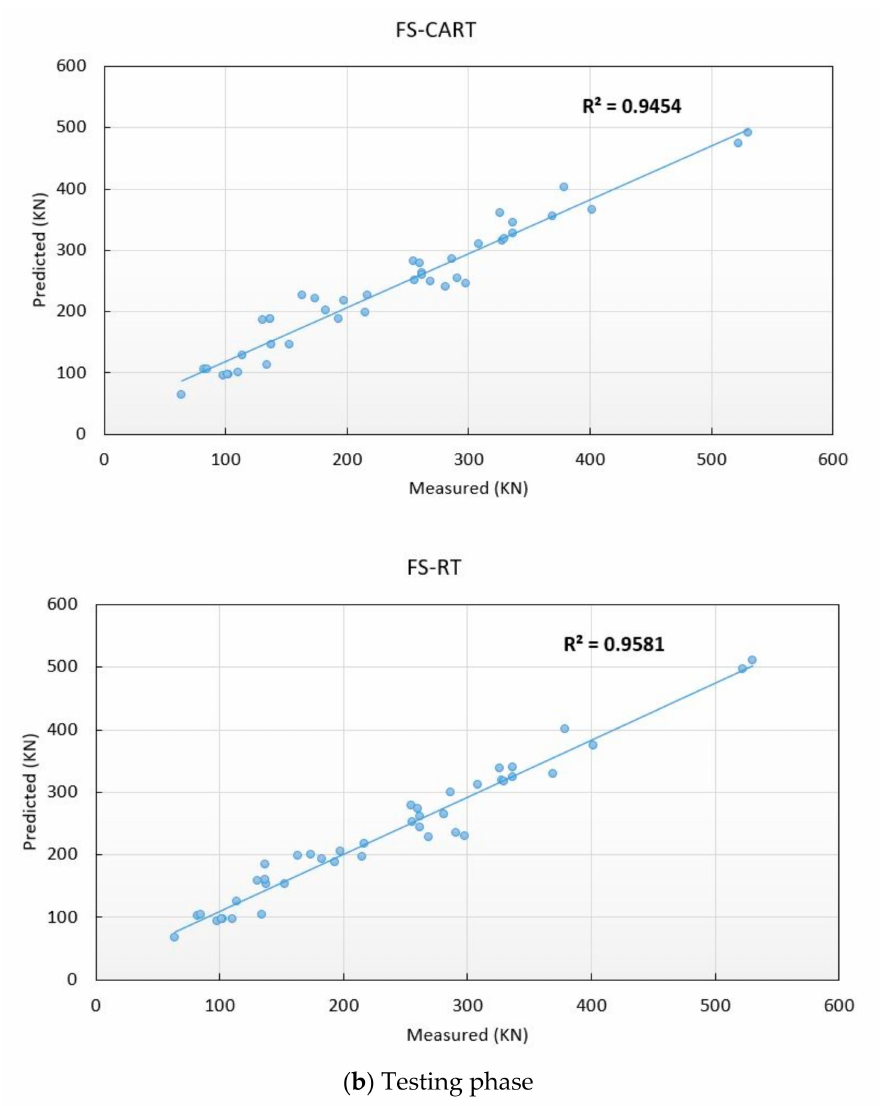
Figure 10. The correlations between measured and predicted punching shear capacity of the SFRC flat slabs by hybrid models. ( a ) training phase, ( b ) testing